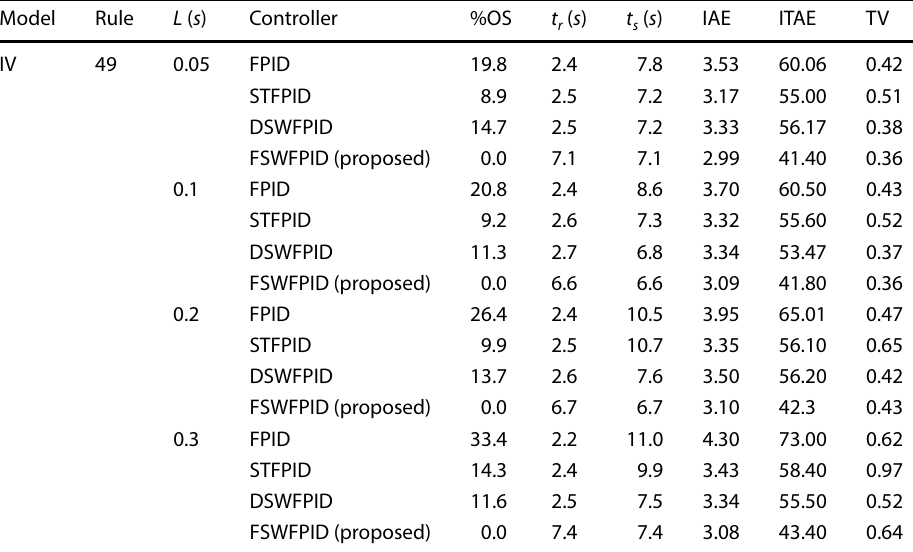
Table 12 Performance analysis for Model